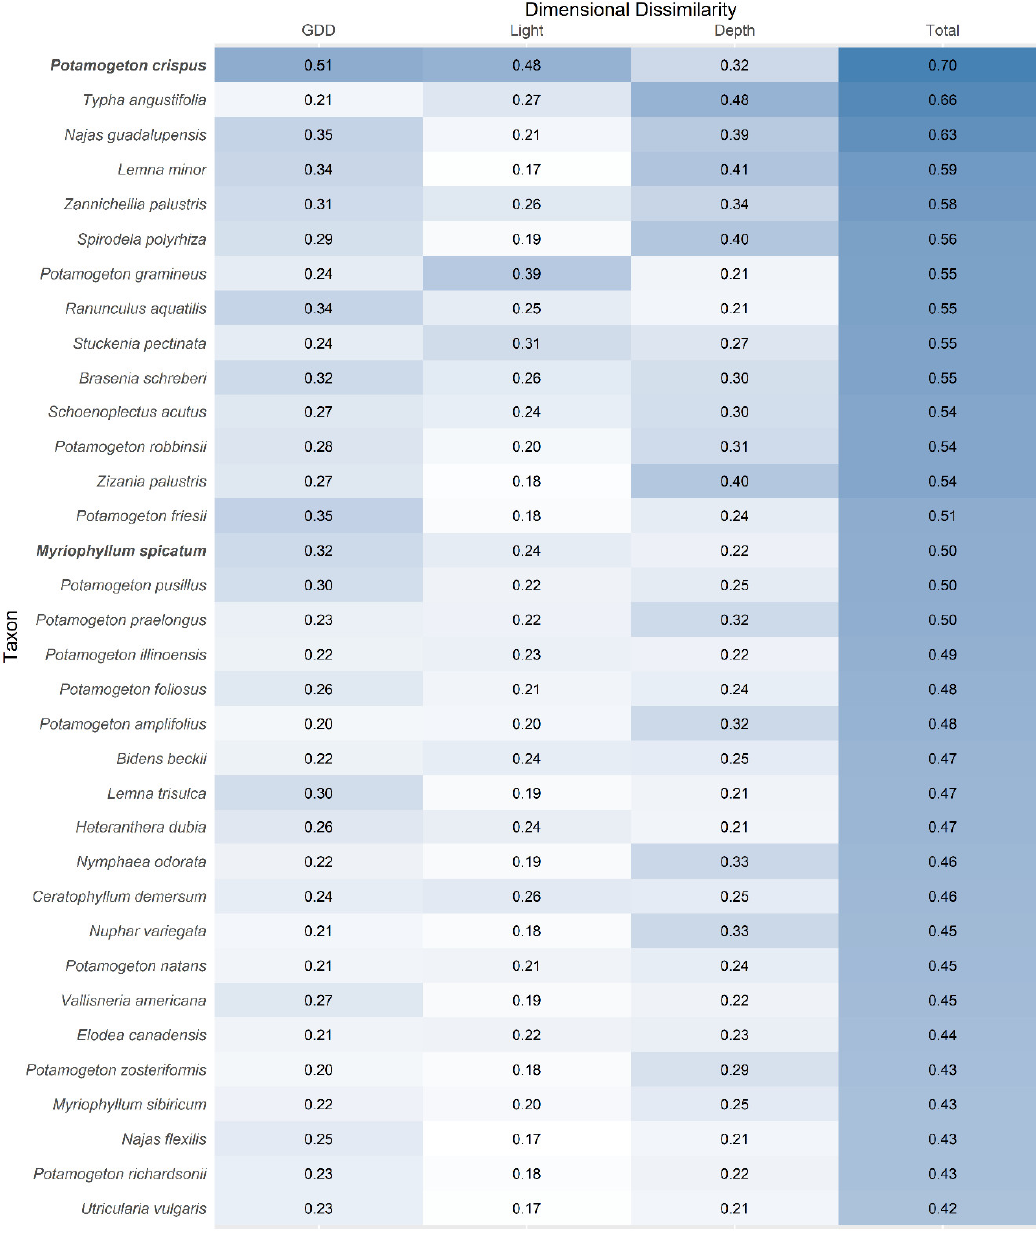
Figure 6. Comparison of the dimensional dissimilarity of all species evaluated. The focal invasive species are denoted with boldface font. Species are sorted according to their total dissimilarity to other species (mean of each species’ 33 pairwise comparisons). Shading corresponds with numeric values to facilitate visual comparisons.